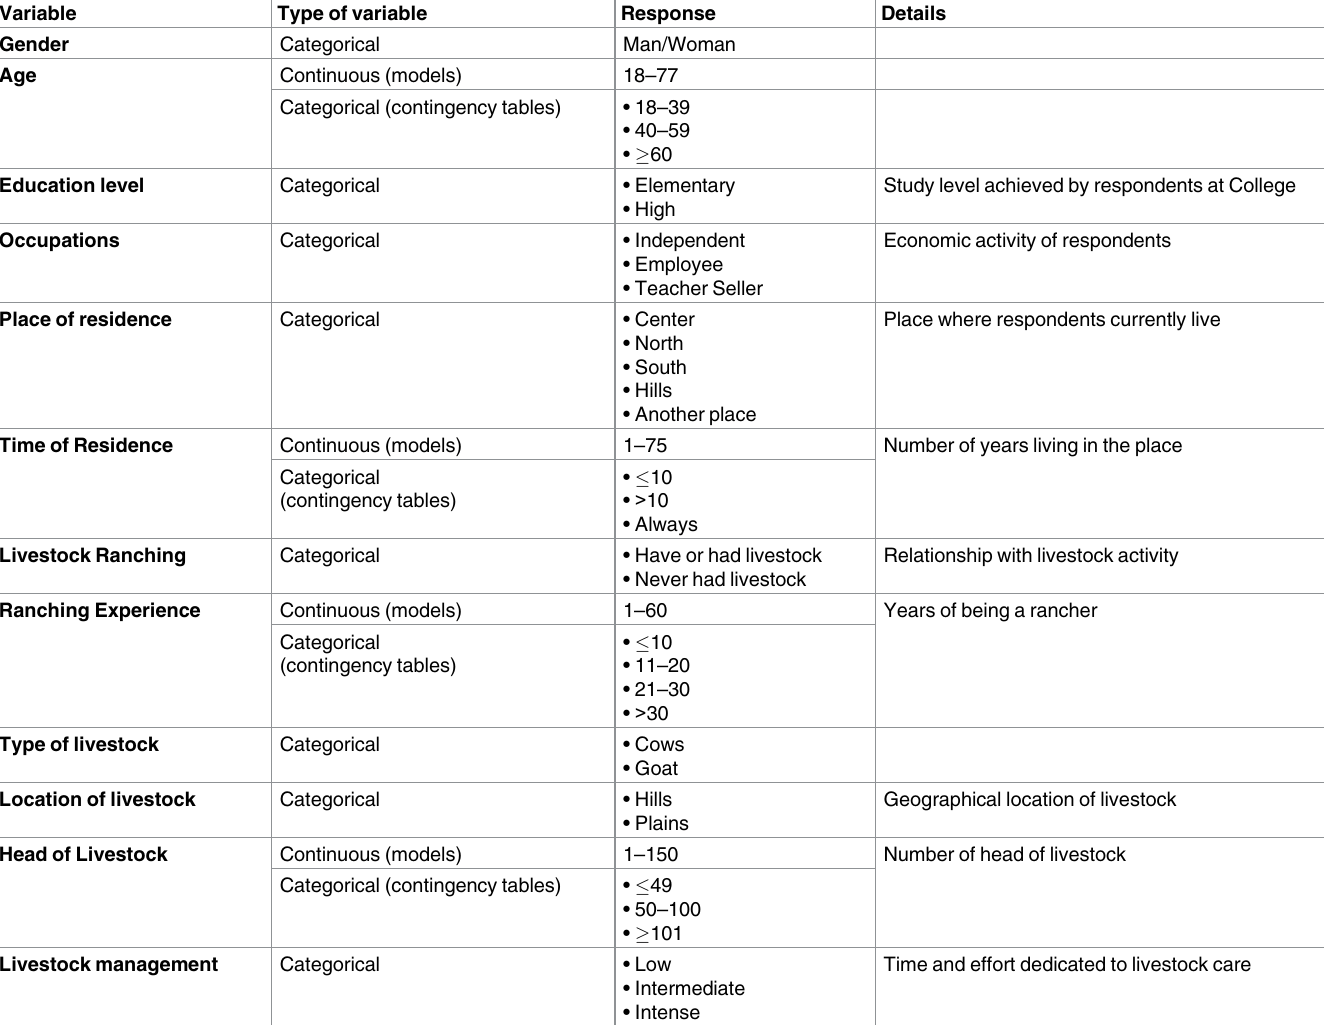
Table 1. Explanatory variables used to analyze people’s perception on Andean